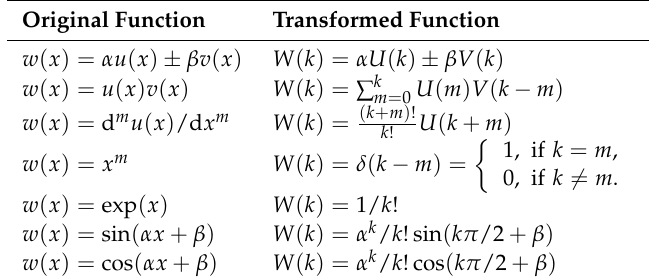
Table 1. The fundamental operations of the differential transform method (DTM). Original Function Transformed